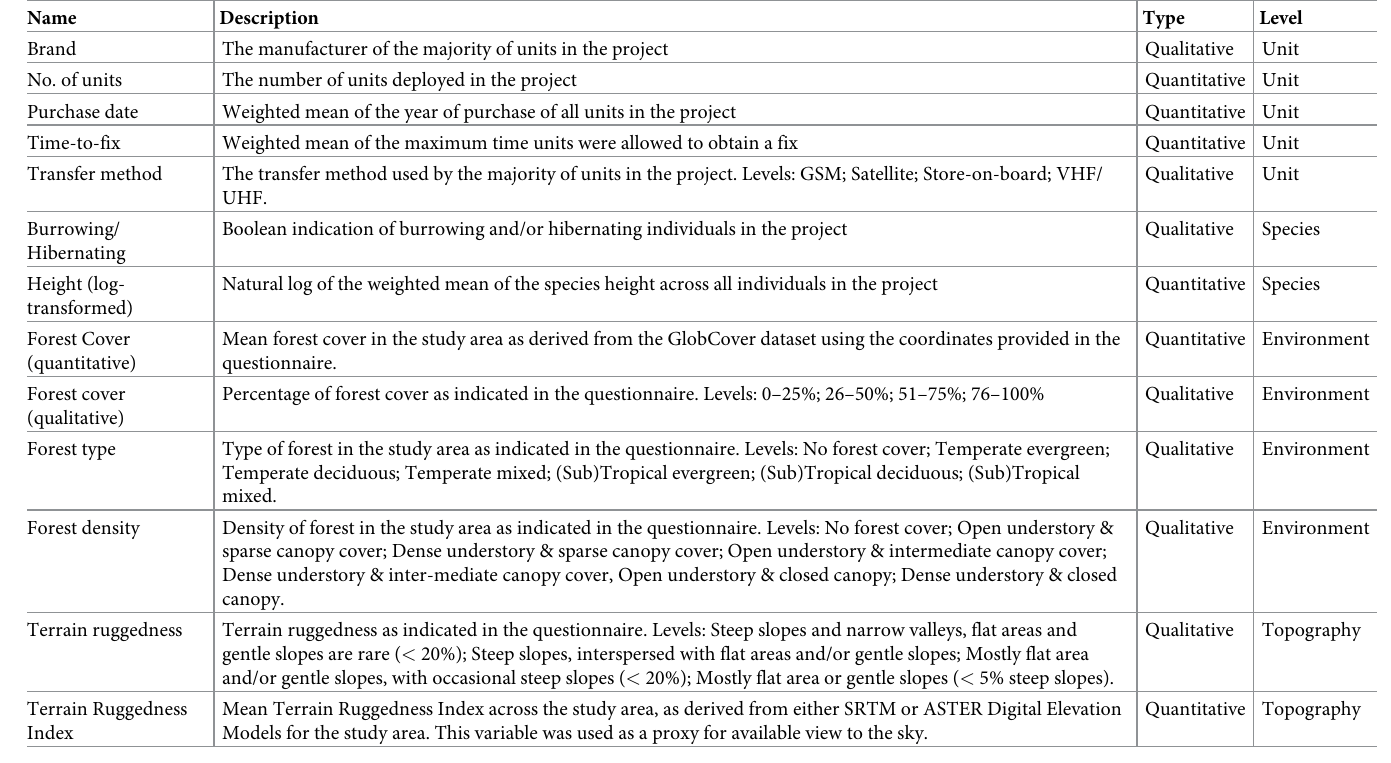
Table 1. Boosted beta regression